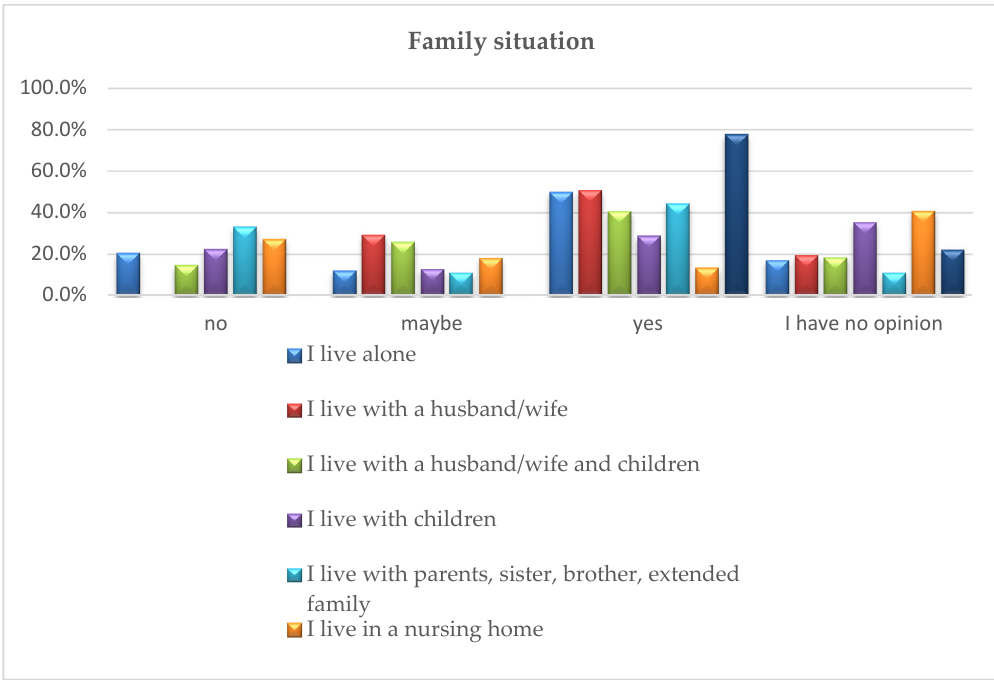
Figure 4. Family situation of the respondents vs. opinion about developing special sales offers of apartments/houses for senior citizens.